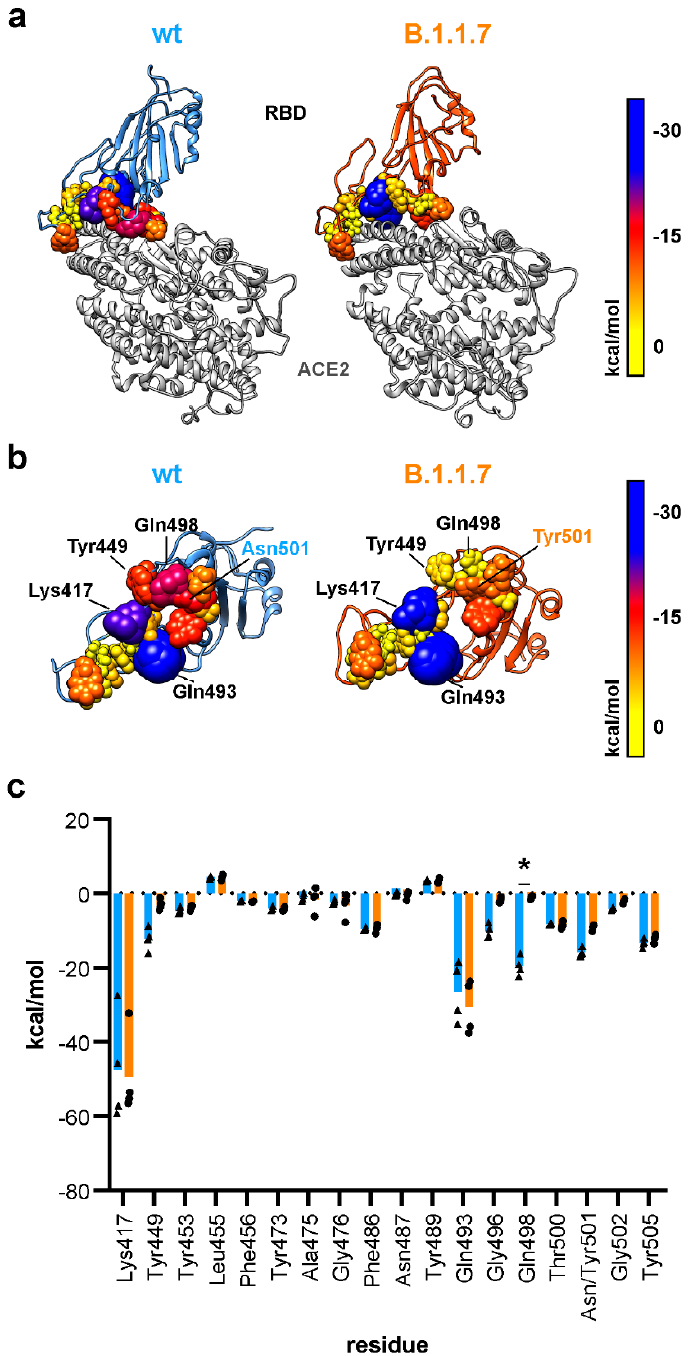
Figure 3. Electrostatic affinity between the RBD and ACE2. ( a ) Structural representation of the RBD (wild type, wt: blue; B.1.1.7: orange) in complex with ACE2 (grey). RBD residues with atoms within a maximum distance of 4 Å from ACE2 are shown as spheres with radii and colors according to their electrostatic linear interaction energy to ACE2. ( b ) View of the interacting interface of the RBD with ACE2. Residue color and atom size represent their electrostatic linear interaction energy to ACE2. ( c ) Quantification of electrostatic linear interaction energy for all residues within 4 Å distance of ACE2 ( n = 4; two-way ANOVA; statistical significance assumed for * p < 0.05; full list of results in Table S4).